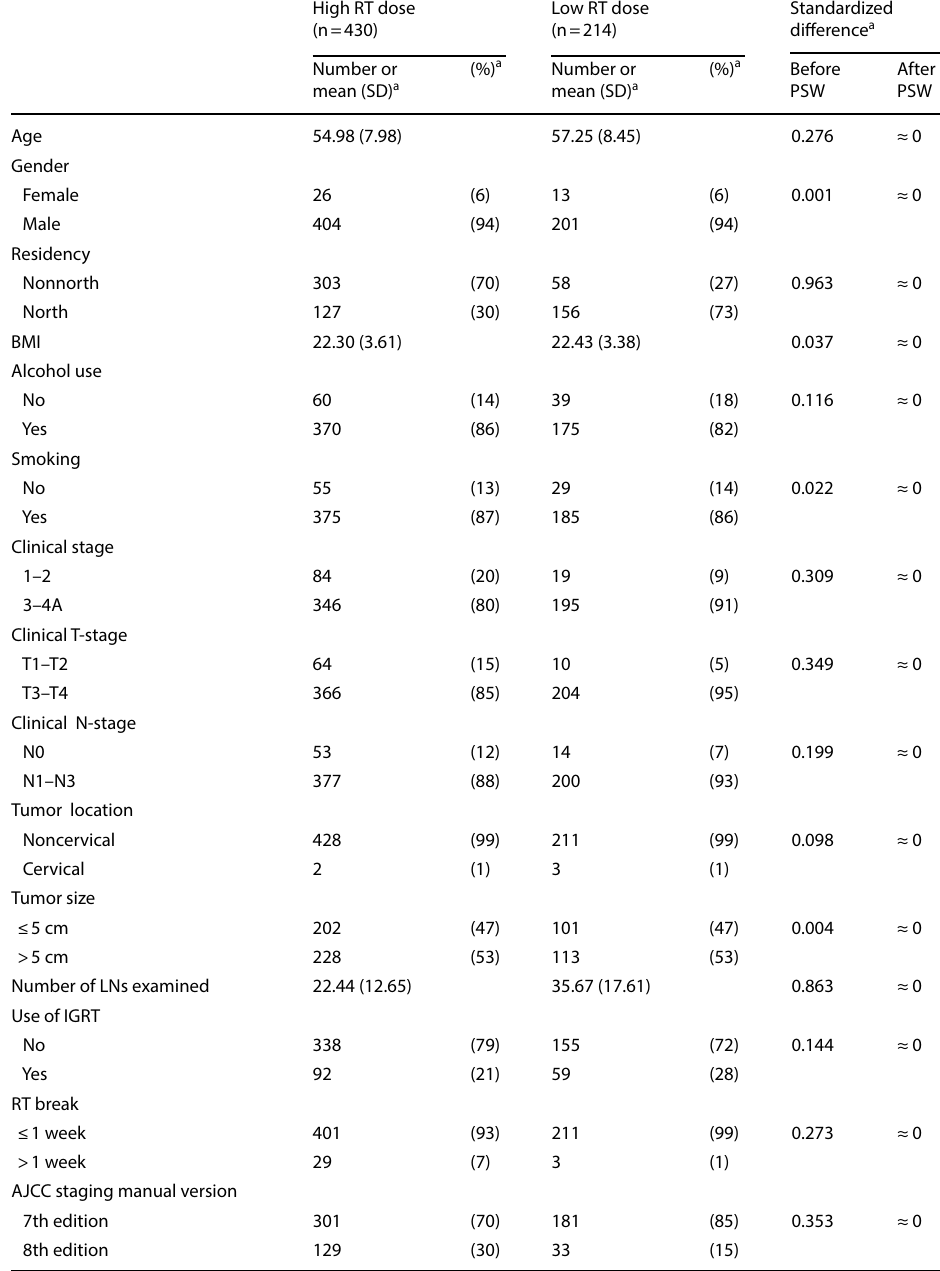
Table 1 Patient characteristics of the study population in the primary